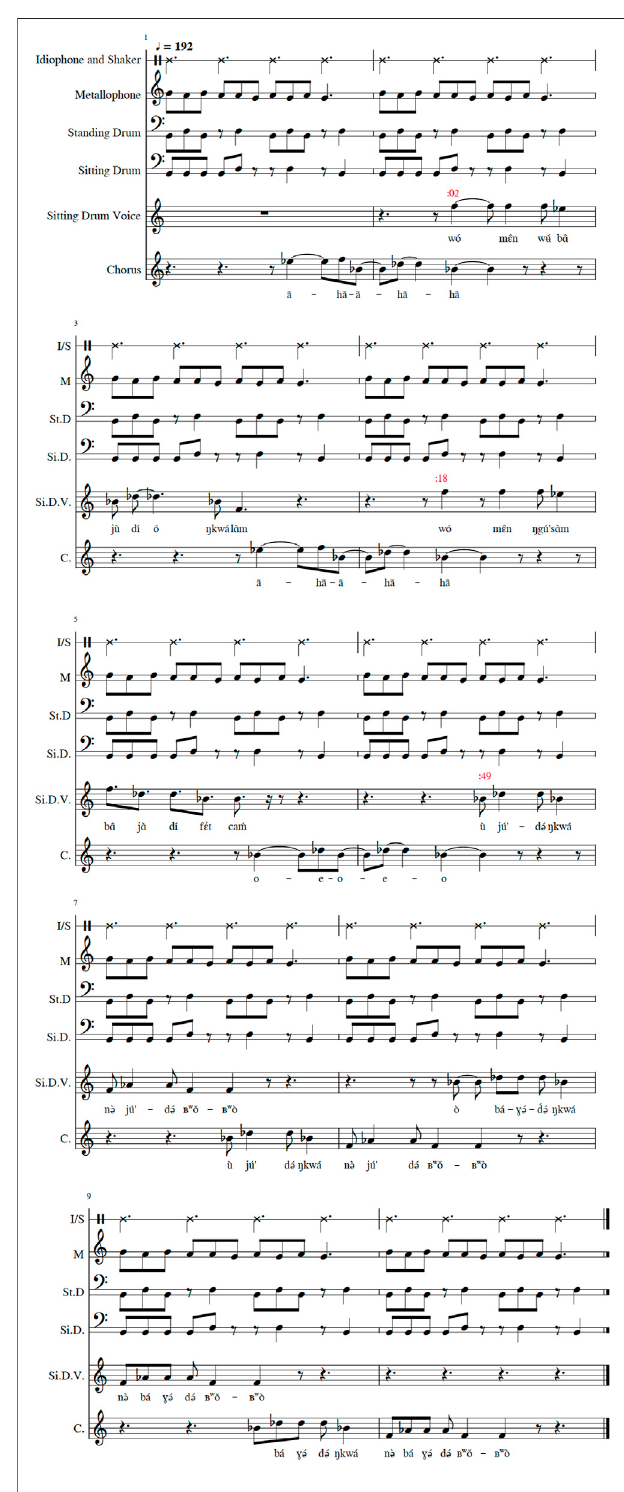
FIGURE 3 | Staff transcription of Song 1. FIGURE 4 | Staff transcription of Song